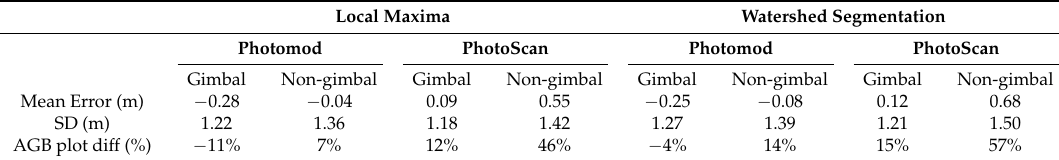
Table 6. Matched tree height differences (mean error values and standard deviations (SD)) and total plot AGB differences based on local maxima and watershed segmentation results (trees height > 10 m). Negative values represent an underestimation. Local Maxima Watershed Segmentation Photomod PhotoScan Photomod PhotoScan Gimbal Non-gimbal Gimbal Non-gimbal Gimbal Non-gimbal Gimbal Non-gimbal Mean Error (m) −